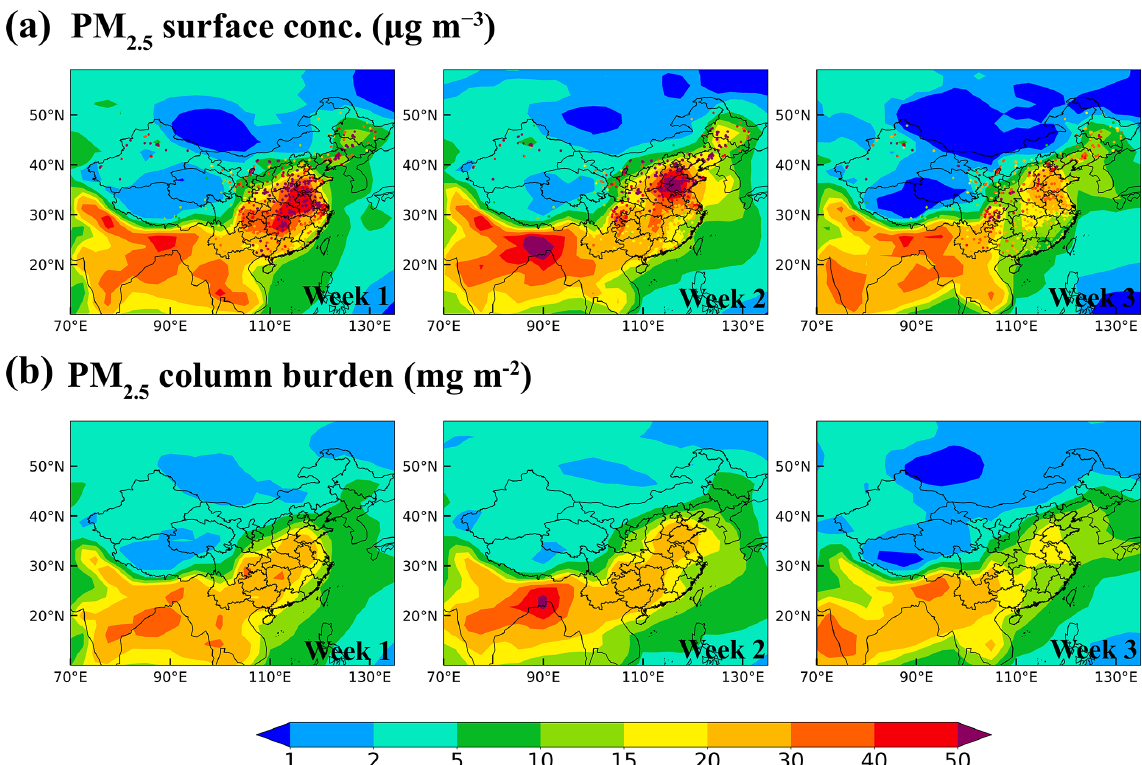
Figure 2. Spatial distribution of (a) the simulated and observed mean near-surface PM 2 . 5 concentrations (µgm − 3 ) and (b) PM 2 . 5 column burden (mgm − 2 ) during 30 January–5 February (week 1), 6–12 February (week 2) and 13–19 February (week